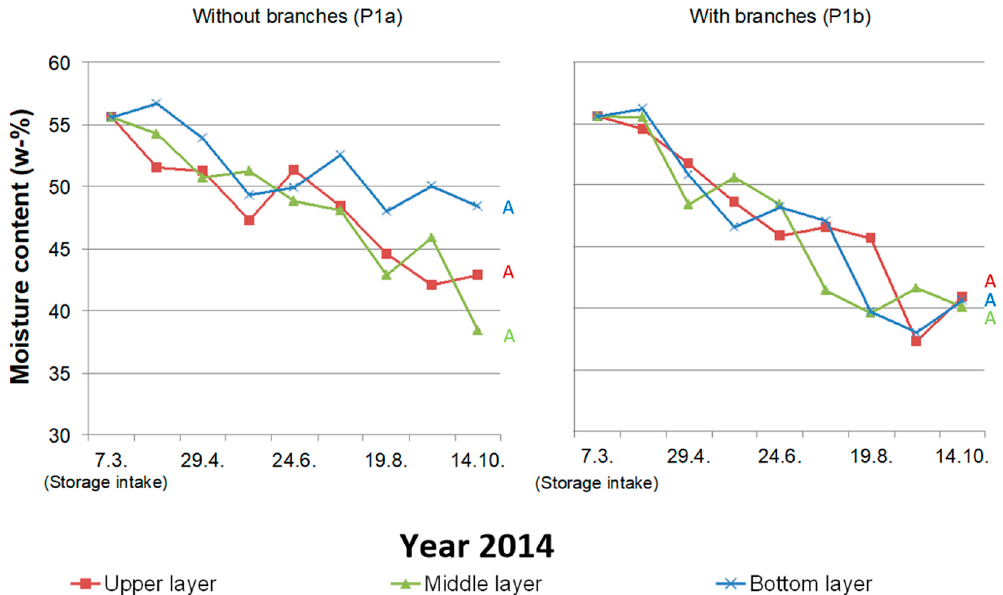
Figure 10. Development of the moisture contents in the pile layers for trial P1 in Potsdam (Different letters indicate significant differences between treatments for α = 0.05, F-test).